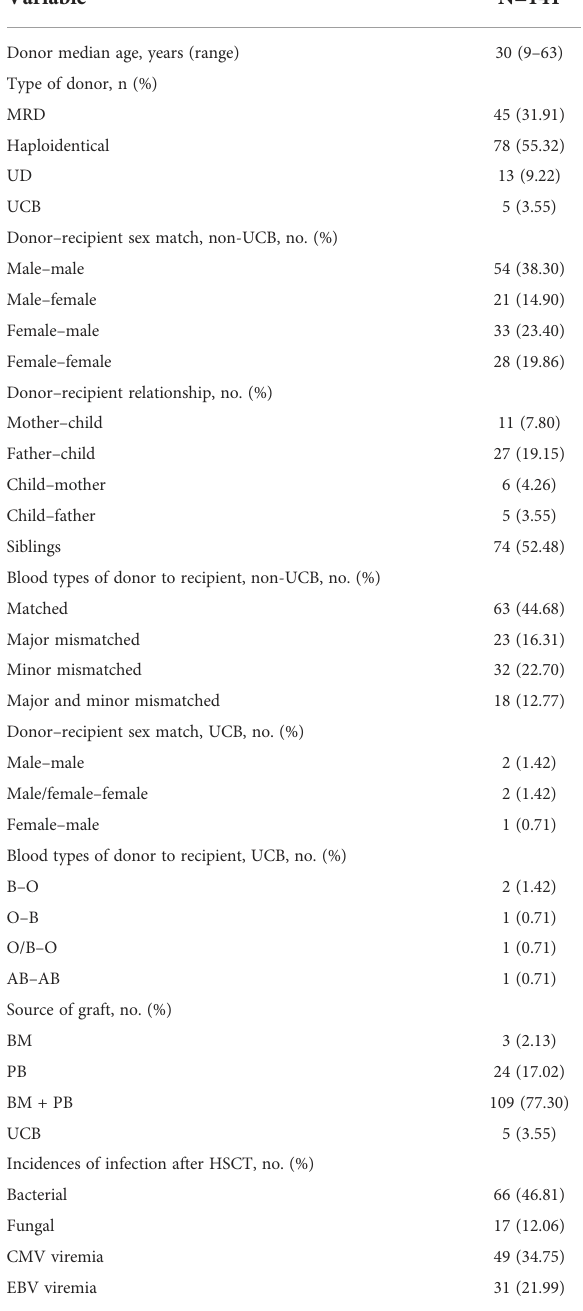
TABLE 2 Characteristics of SAA patients and donors in HSCT